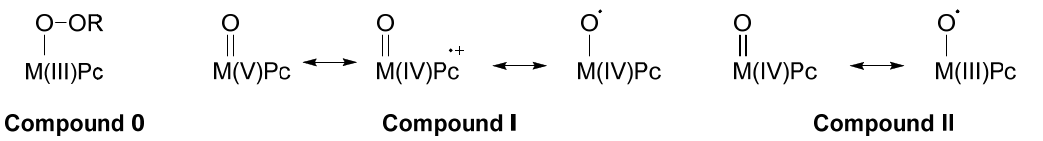
Figure 4. Complexes or hypervalent derivatives of MPcs formed upon reaction of a suitable M(III)Pc with a generic hydroperoxide R–O–OH.